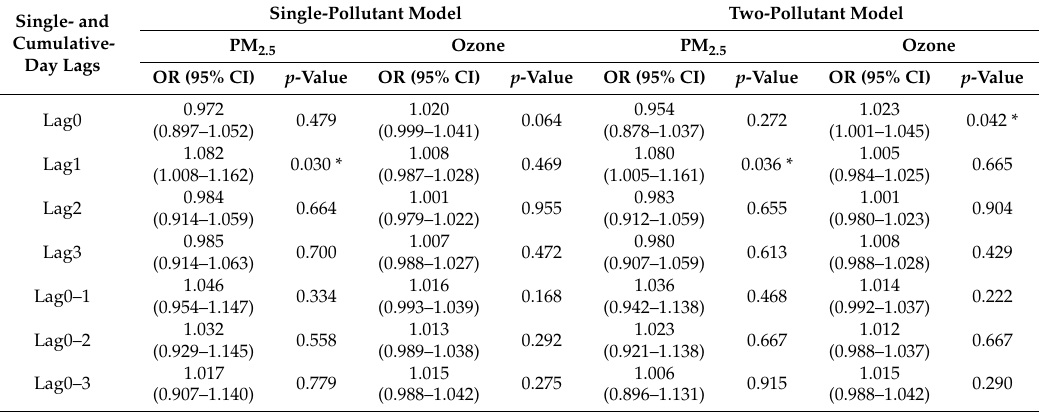
Table 3. Results of the conditional logistic regression models between ambient air pollution and hospital